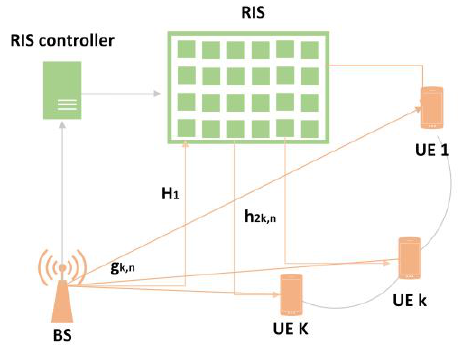
Figure 3. RIS-assisted cell mMIMO communication system.